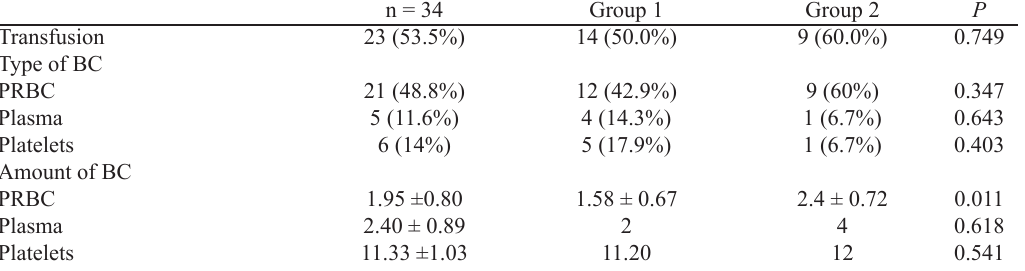
Table 3. Use of blood